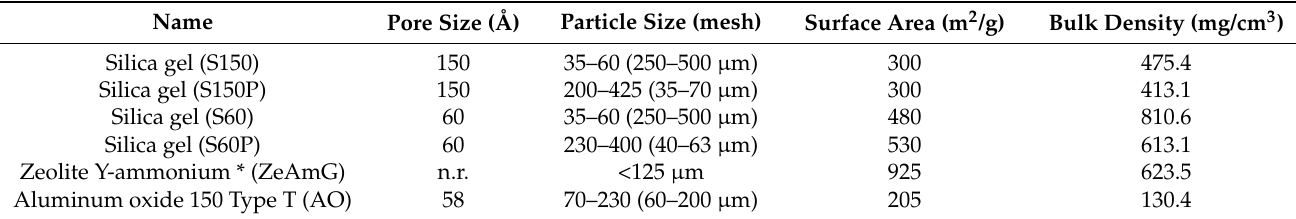
Table 1. Summary of the most relevant adsorbent’s